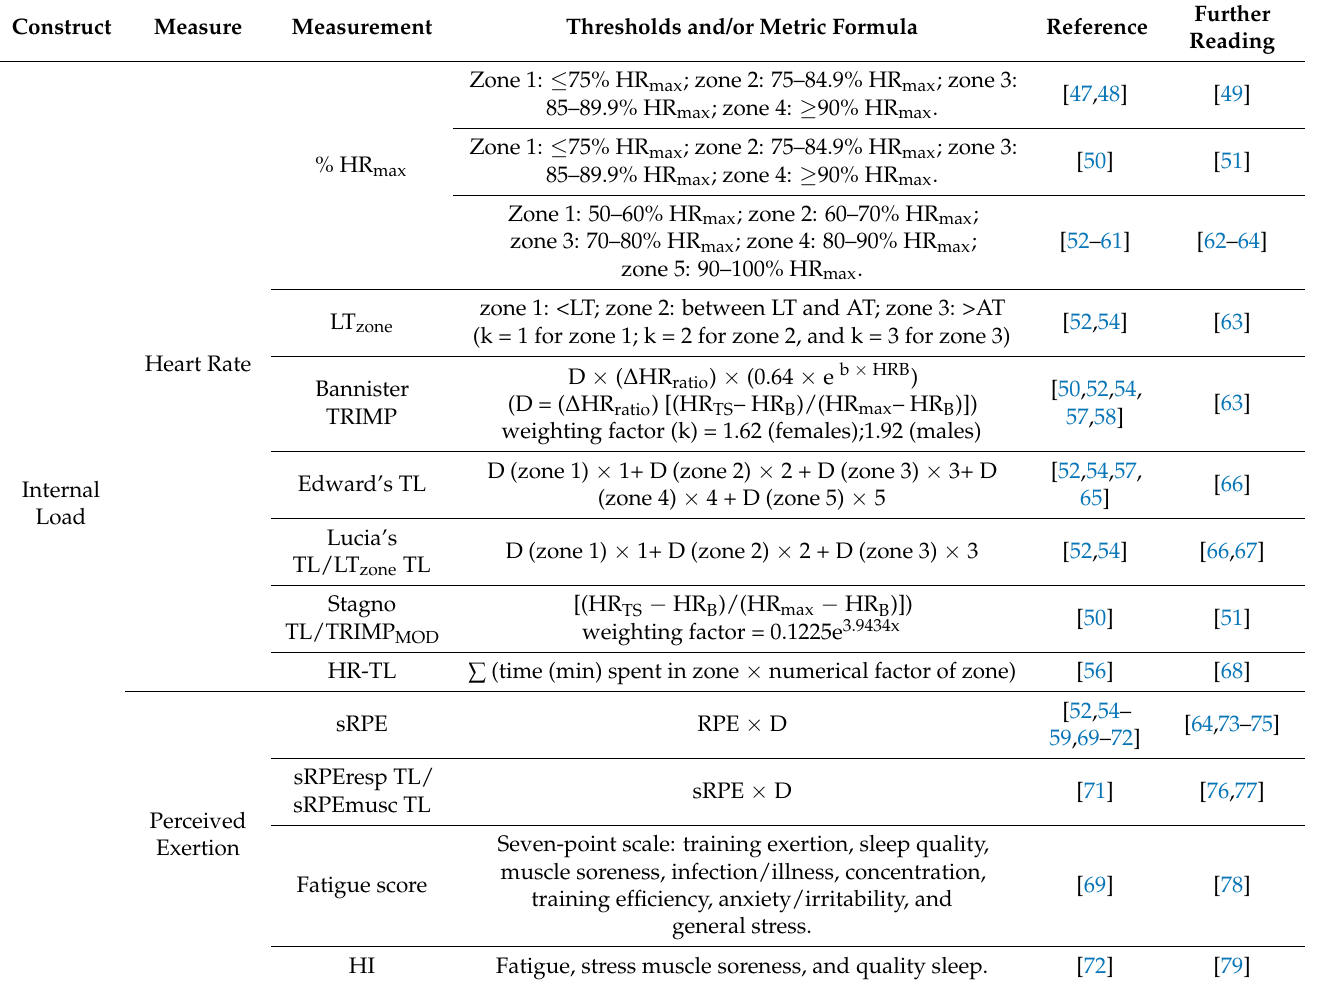
Table 2. Summary of measure and measurements in the included